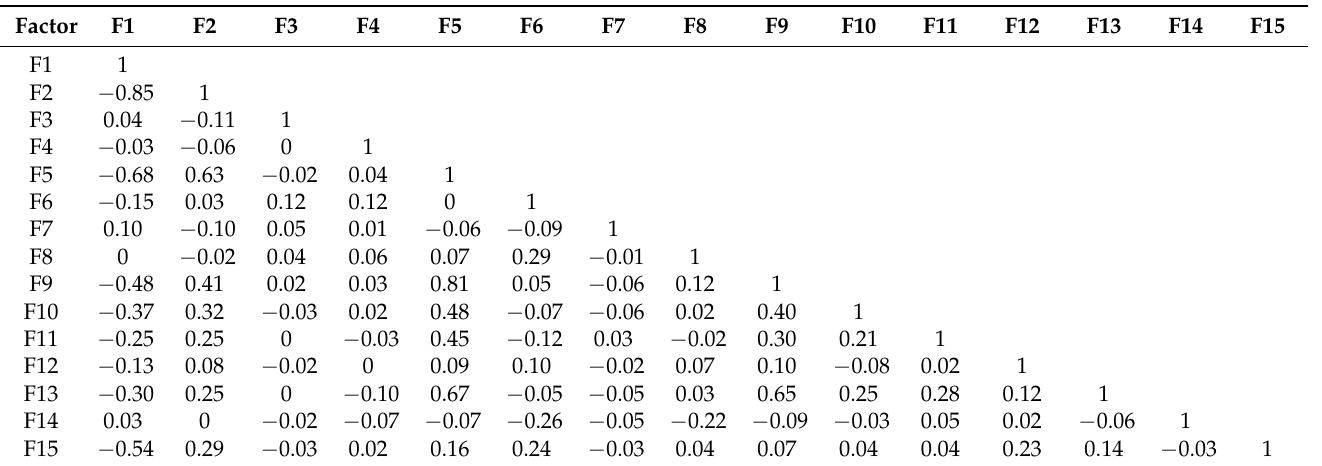
Table 3. Causative factor categories for